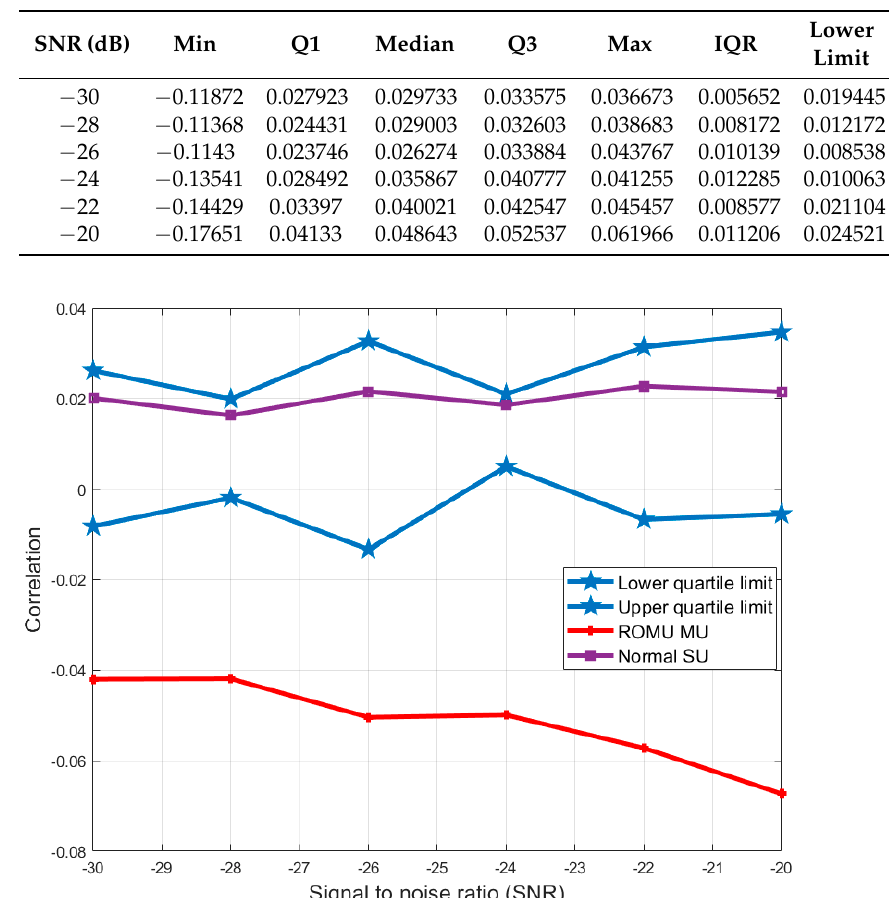
Table 2. Box-whisker plot data of the correlation results under OMU users only.